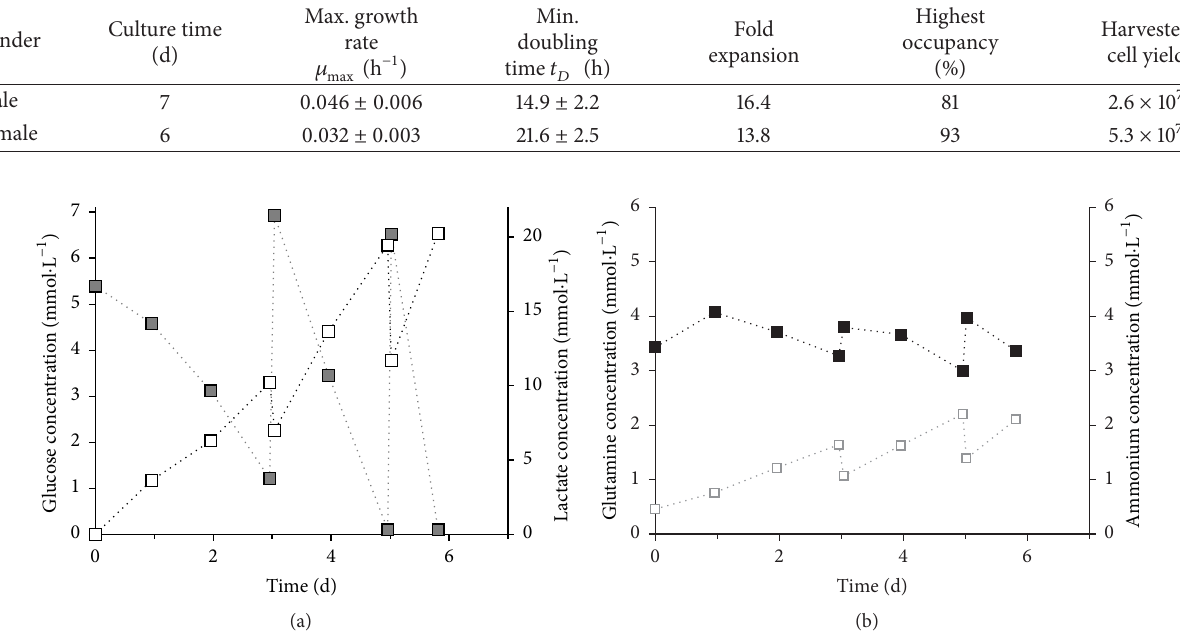
Figure 6: Metabolite profile of hUC MSCs from a female donor (HUC #255) in a dynamic spinner culture with 25 g ⋅ L −1 , 100mL DMEM LG medium, and a seeding density of 8000 cells ⋅ cm −2 . (a) Grey full—glucose, white empty—lactate; (b) black full—glutamine, grey empty— ammonium.